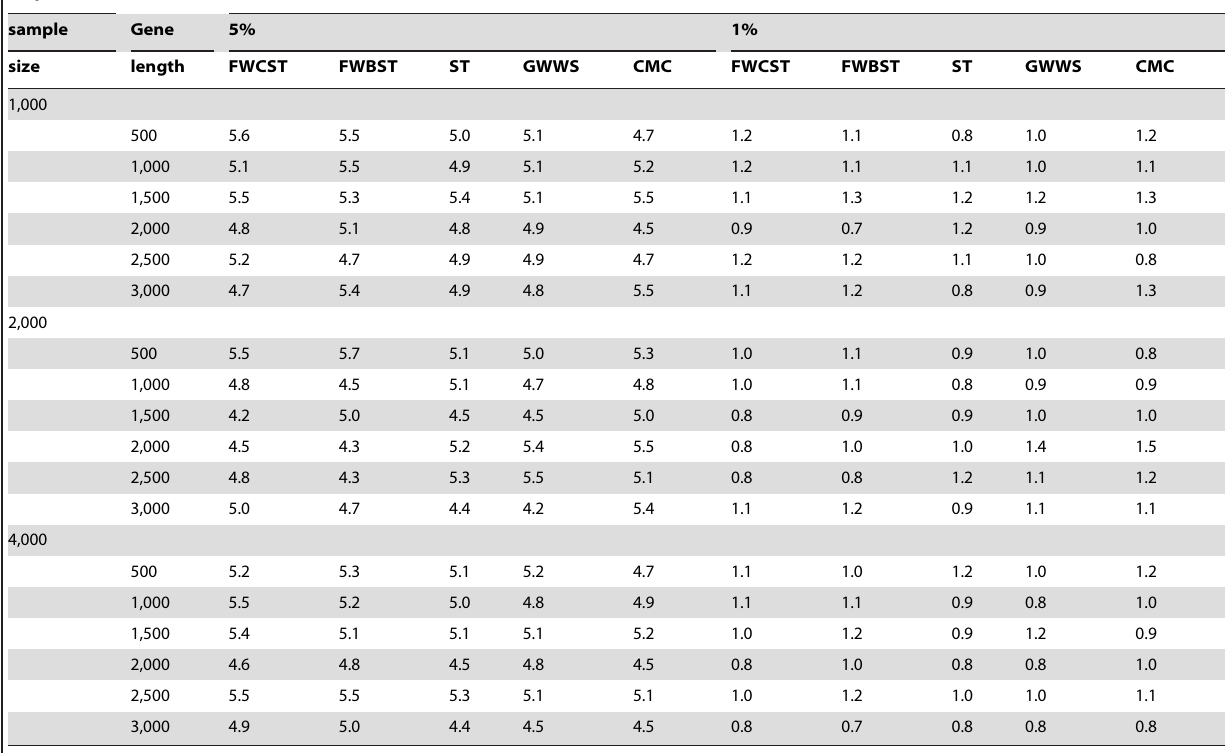
Table 1. Type I error